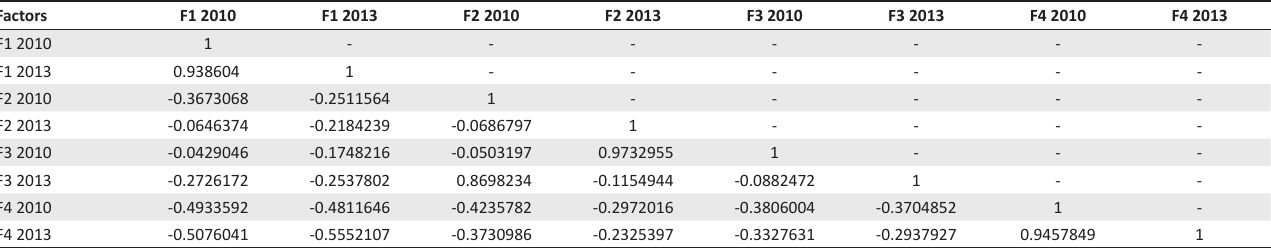
TABLE 10: Factor correlation matrix (2010 and 2013).